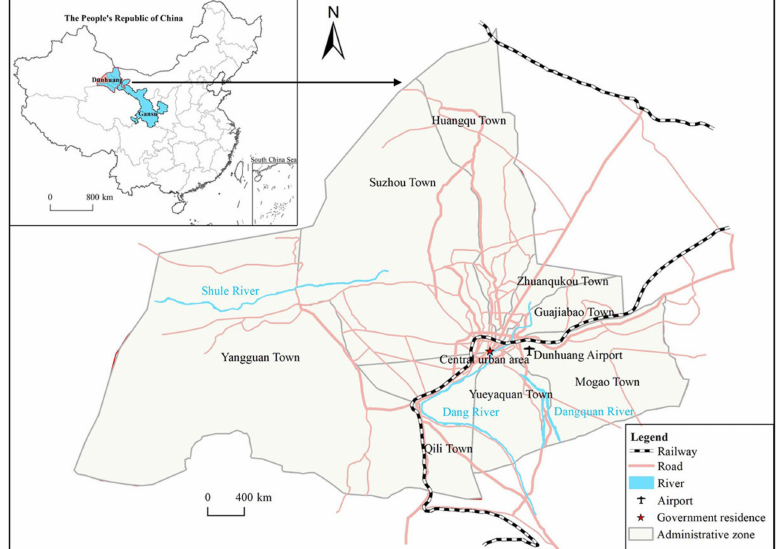
Figure 2. The location of Dunhuang